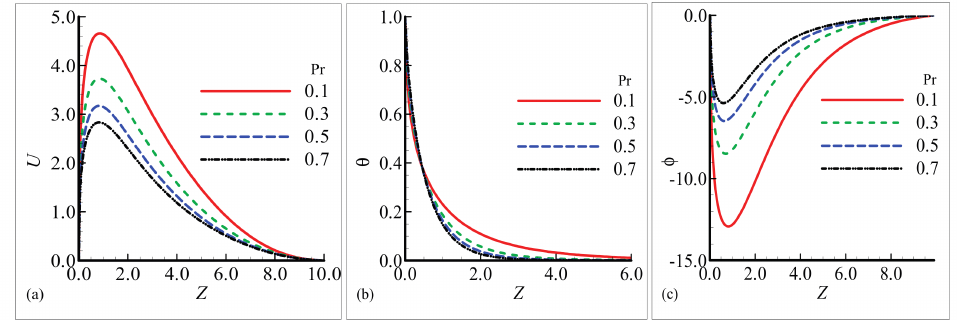
Figure 15. Physical e ff ects on quantities ( a ) u , ( b ) θ , and ( c ) φ versus Pr, when Nt = 0.1, Nb = 0.4, Q = 0.2, M = 0.2, Sc =